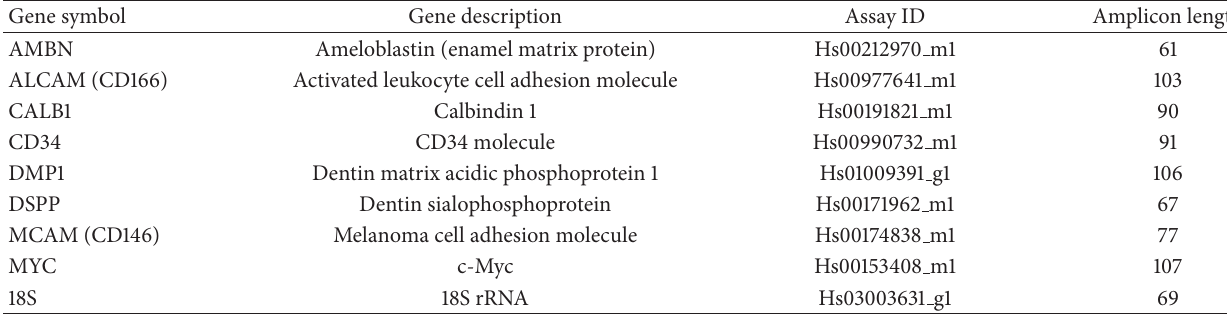
Table 1: Quantitative RT-PCR primer